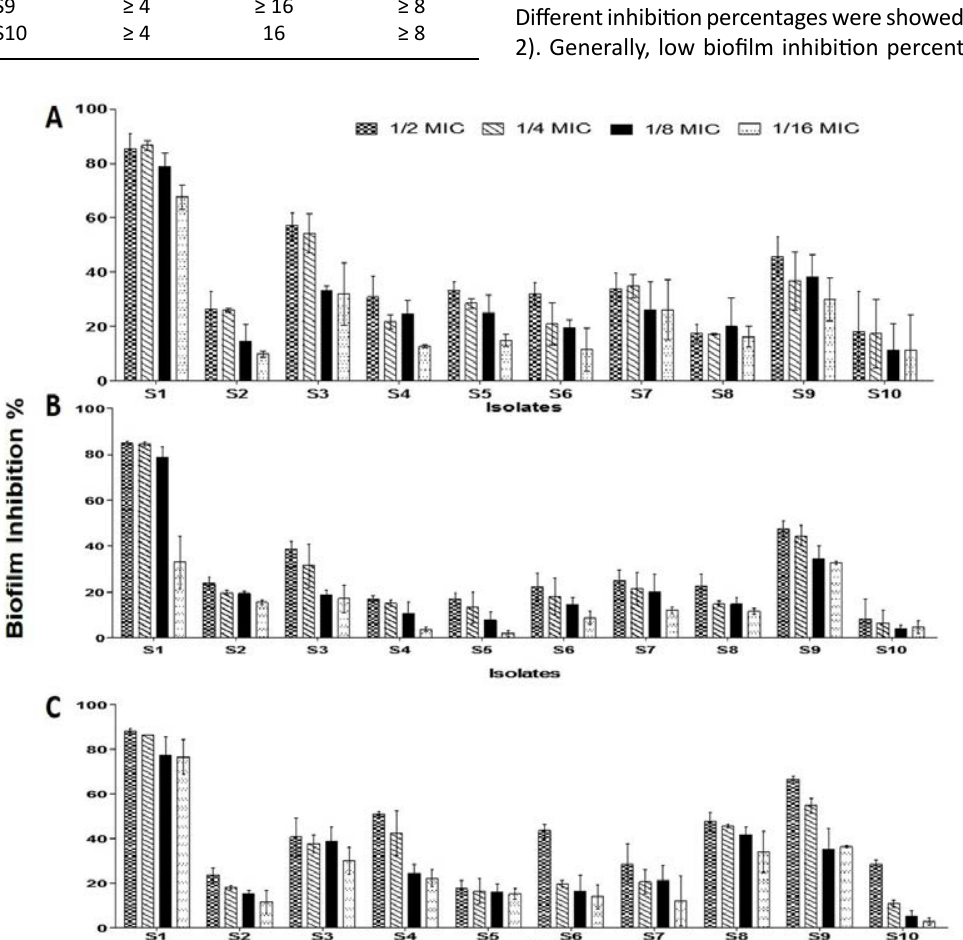
Fig. 2. Effect of different antibiotics concentrations on MRSA strains biofilm formation. (a) Gentamycin (b) Ciprofloxacin and (c) Erythromycin. The bars on the graph represent mean ± SD as a percentage of biofilm inhibition/ eradication of triplicate independent experiments (n =